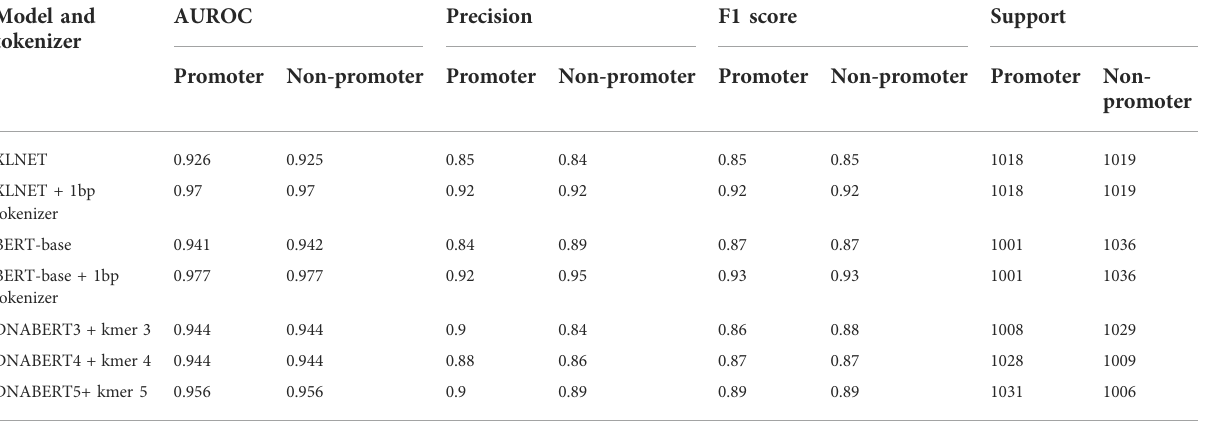
TABLE 2 Performance of popular transformer-based NLP models for promoter